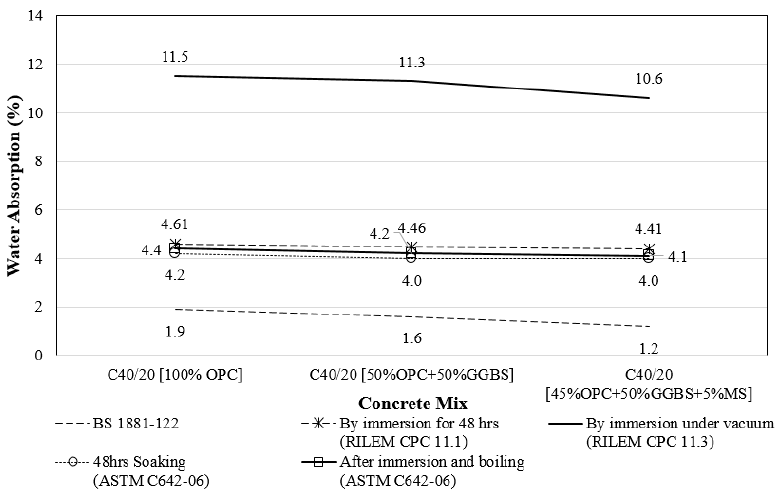
Figure 5. Impact of SCMs replacement percentages on the porosity of concrete under different standard test methods.